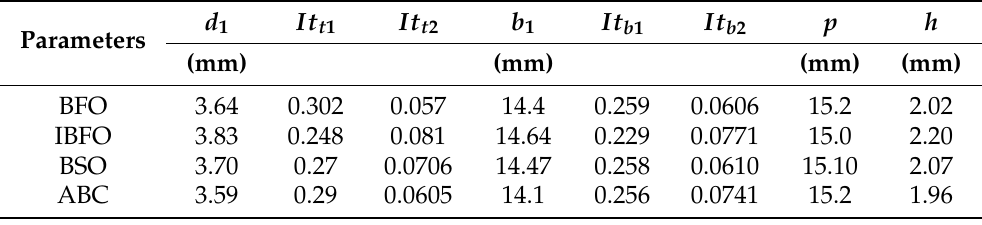
Figure 6. Evolutionary process of average fitness value for different algorithms.